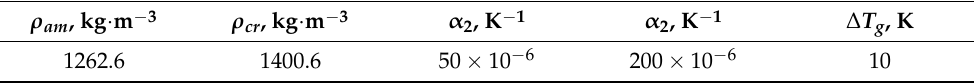
Table 4. Thermomechanical values of Table 3. Values of constants for calculating the dependence of a complex modulus.